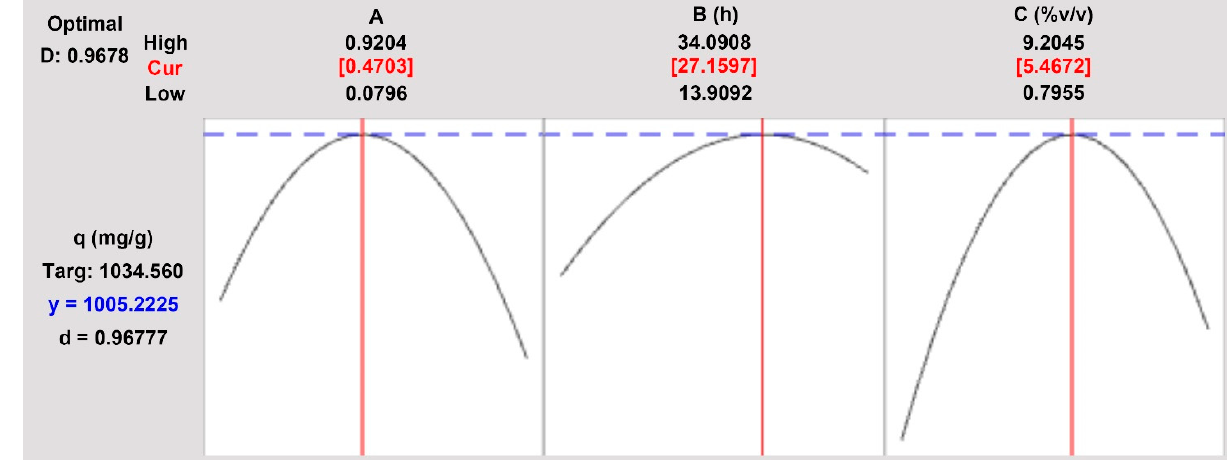
Figure 4. Optimization plot. Table 3. Validation of optimization